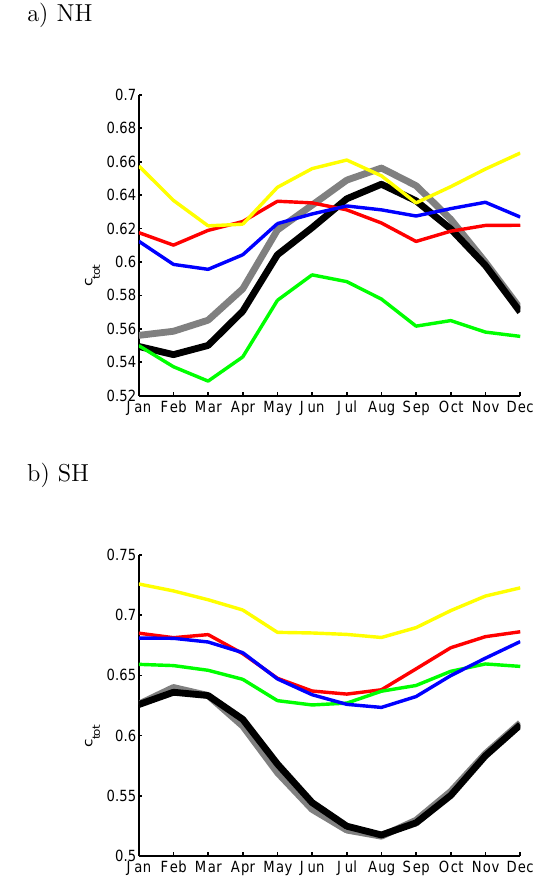
Fig. 1. Total cloud fractions (fraction) averaged over the Northern and Southern Hemispheres ( a and b respectively) for the model with initial guess and calibrated parameter sets (gray and black lines correspondingly) as well as for the ISCCP, MODIS, CERES, and ERA-40 data sets (red, yellow, green, and blue curves correspondingly).